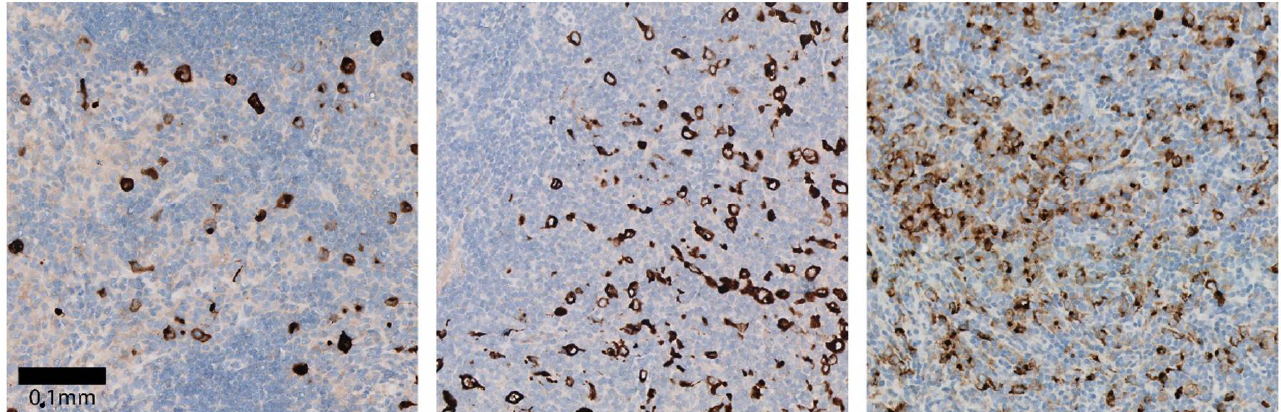
Figure 3. Positive TARC staining of HRS cells (brown) by immunohistochemistry in lymphoma tissues slides of three different pediatric cHL patients. Scale bar depicts 0.1 mm size, all images were made with the same magnification.